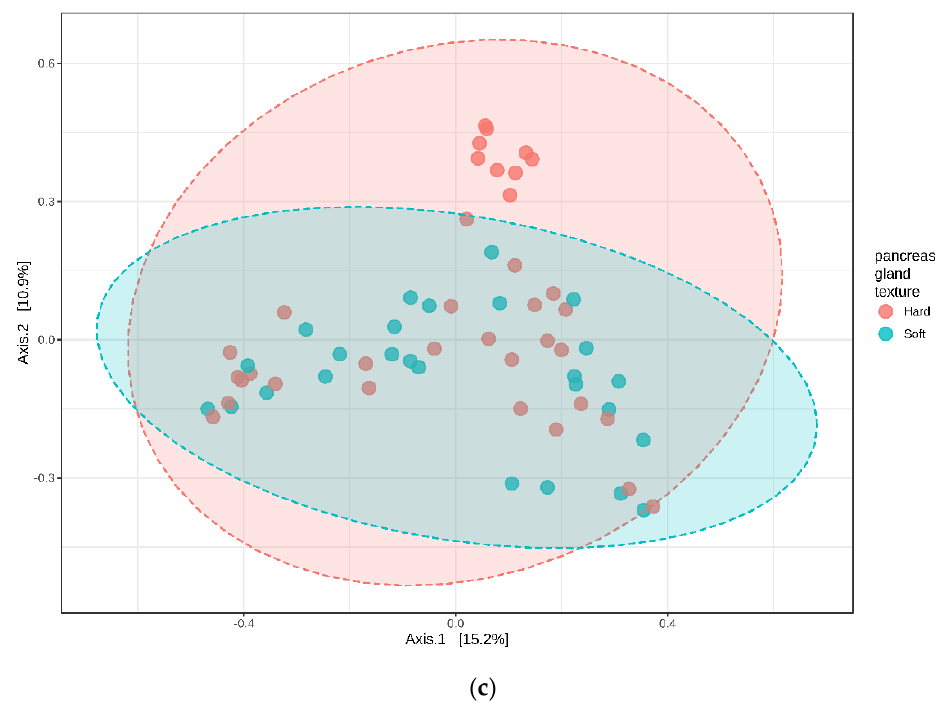
Figure 7. Bar plots representing the relative abundance of the bacterial composition detected in the two tissue types (hard and soft) from all tested sample sites. ( a ) phylum level; ( b ) genus level; ( c ) beta diversity comparison between the two groups shown by PCoA plot (PERMANOVA, Jaccard index, p -value < 0.043, F-value 1.5847, R = 0.025) in hard gland texture (Hard, red) and soft gland texture (Soft, blue).